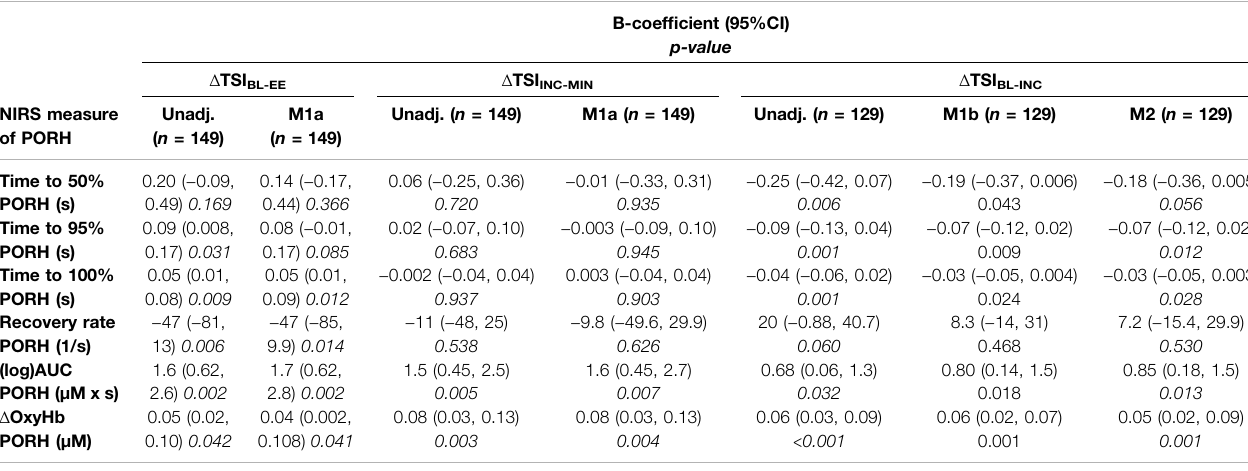
TABLE 2 | Associations between TSI, tissue saturation index; changes during exercise and indices of post-occlusive reactive hyperaemia (PORH); measured in the lower- limbskeletalmuscle. Δ TSI BL-EE isthechangeintissuesaturationindex(TSI);betweenrest(baseline,BL)andtheEE,endofexercise; Δ TSI INC-MIN isthechangeinTSIfrom it is highest point at the INC, increment; to it is MIN, minimum; Δ TSI BL-INC is the change in TSI from the BL to the highest point (INC). unadj, Unadjusted; and adjusted β - coef fi cients, 95% con fi dence intervals and p -values are presented for each association. M1a, Model 1a; is adjusted for age, sex, ethnicity, the duration of the ischaemic stimulusandtheestimatedworkloadachievedduringthesteppingtest.M1b,Model1b;isadjustedforage,sex,ethnicityandthedurationoftheischaemicstimulus.M2, Model 2; is adjusted for age, sex, ethnicity, mean arterial pressure (MAP); change at the start of exercise.